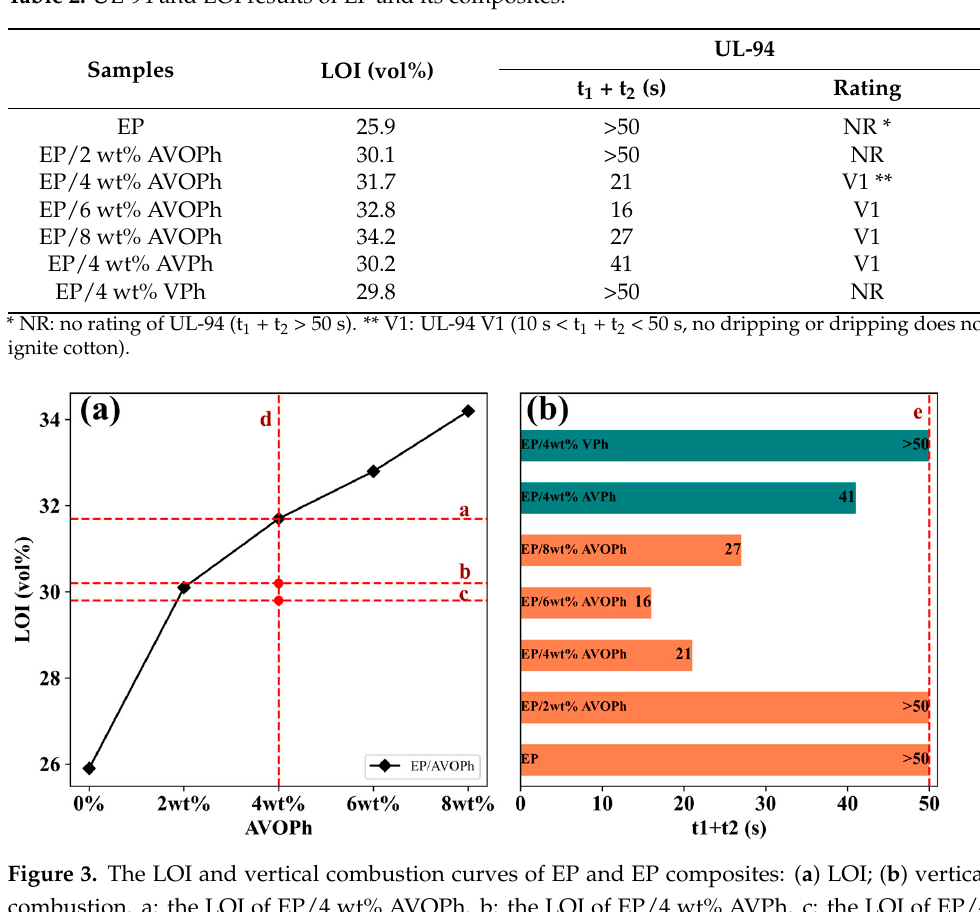
Table 2. UL-94 and LOI results of EP and its composites.